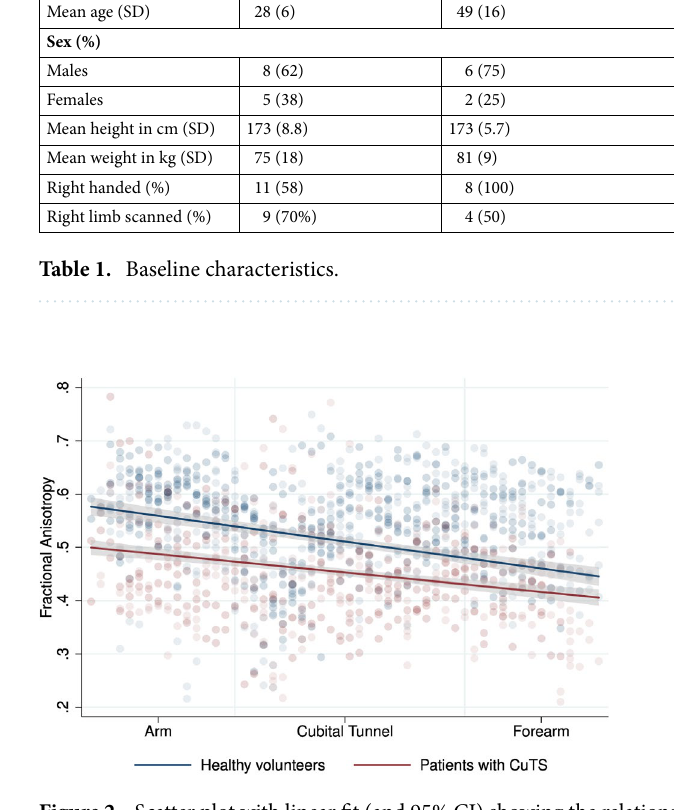
Figure 2. Scatter plot with linear fit (and 95% CI) showing the relationship between fractional anisotropy of the ulnar nerve in volunteers and patients, at different positions within the upper limb.